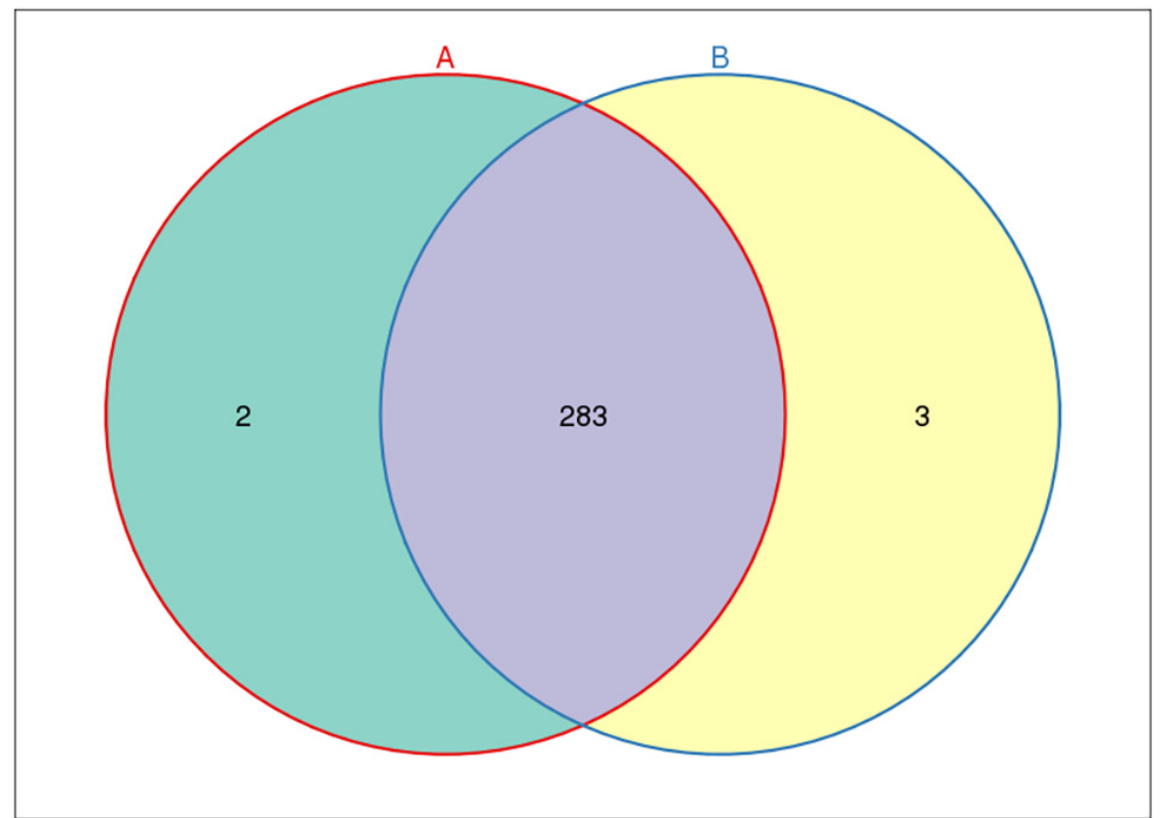
Figure 17. Common and unique OTUs of fecal intestinal flora among groups. Each circle represents the number of fecal microbial OTUs in the feces of each group. The intersection part of the circle represents the number of OTUs shared between groups. The non-intersecting parts represent the number of exclusive OTUs in each group.